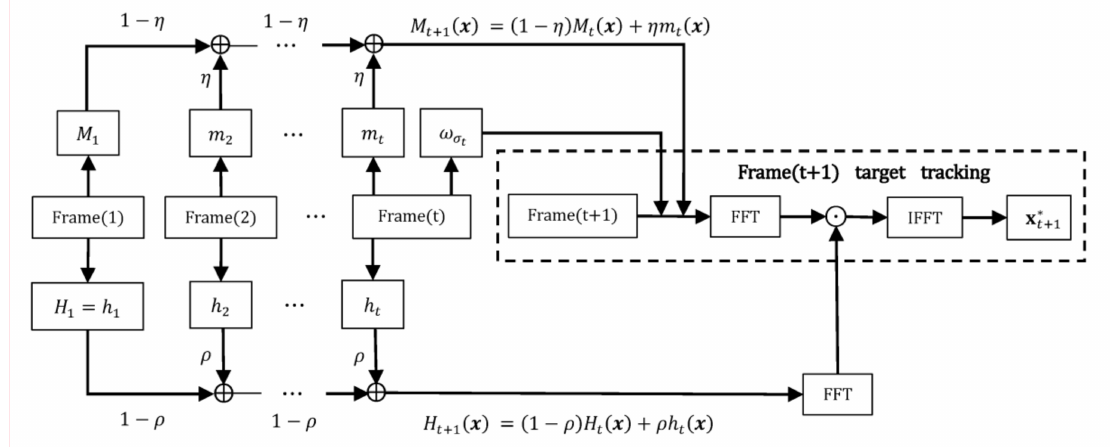
Figure 8. Flow chart of motion-enhanced spatio-temporal context (MSTC)